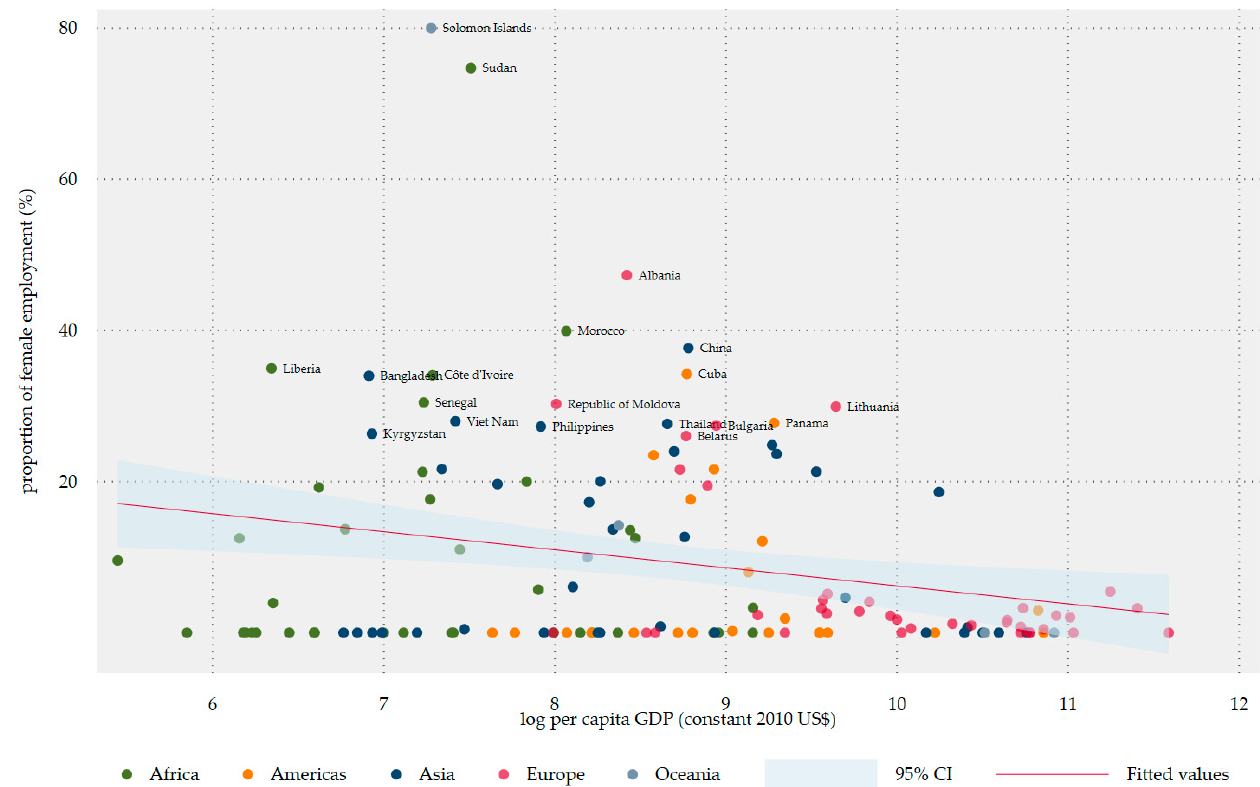
Figure 3. Distribution of female employment participation in the forest cluster in 2015. A high proportion of forest-based female employment in some countries indicate gradual involvement of women in forestry-related economic activities. Countries with the largest proportion of women in national total forest-based employment are Solomon Island with 80 per cent, Sudan with 75 per cent and Albania with 47 per cent. According to the latest FRA country report, most of forestry employment in Solomon Island refers to logging with 7.4 thousand persons FTE being female. In Solomon Island, forest and logging is the second largest contributor to GDP after agriculture. However, the logging industry in the Solomon Islands employs mainly men for logging operations, and women are more represented in the provision of services for camp workers, administrative jobs, collecting foods, medicinal plants and firewood [32]. In Sudan, approximately 1.2 million persons are predominantly employed in the gathering of NWFP activities, accounting for